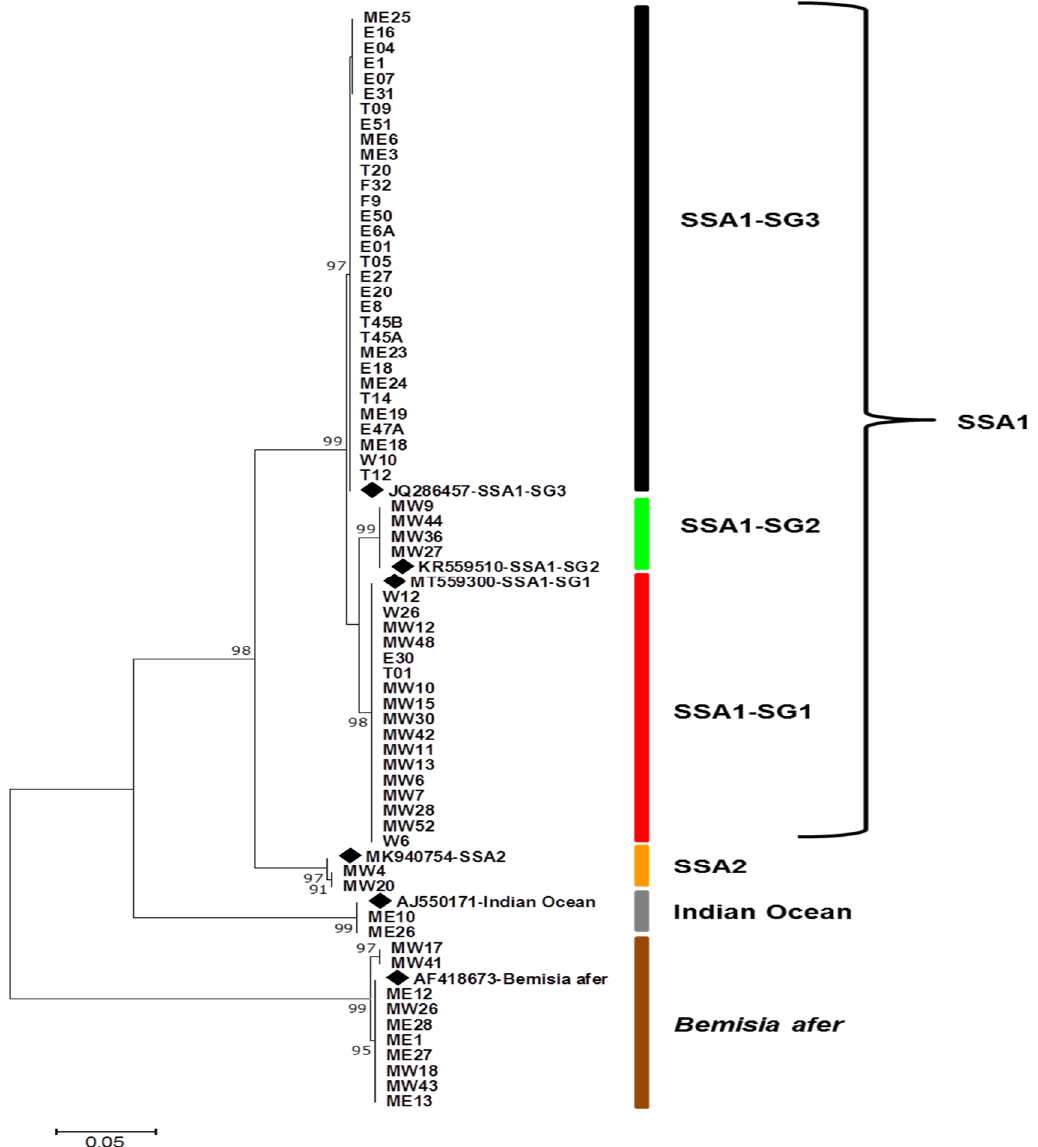
Figure 4. Maximum likelihood phylogenetic tree constructed using mitochondrial cytochrome oxidase 1 sequences obtained from Bemisia tabaci (cassava types) collected in this study. Reference sequences ( (cid:117) ) from NCBI were included for comparison. Only selected sequences are shown in the phylogenetic tree.